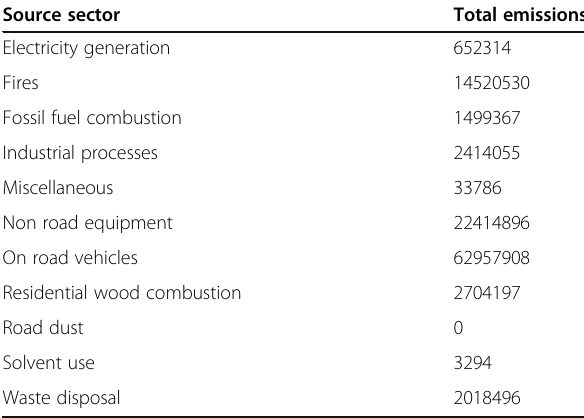
Table 3 Misinformation due to data and cognitive perception Source sector